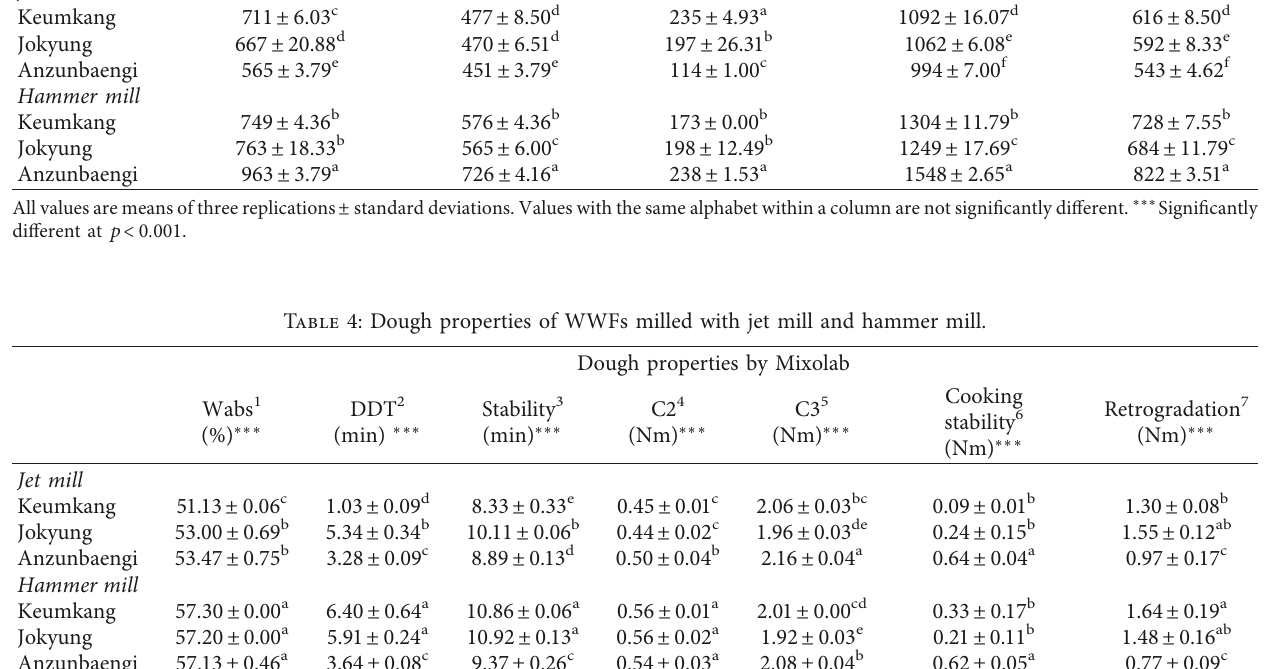
Figure 1: Water absorption index (a) and water soluble index (b) of WWFs milled with jet mill and hammer mill. at p Table 3: Pasting properties of WWFs milled with jet mill and hammer mill. Peak viscosity (cP) Trough (cP) ∗∗∗